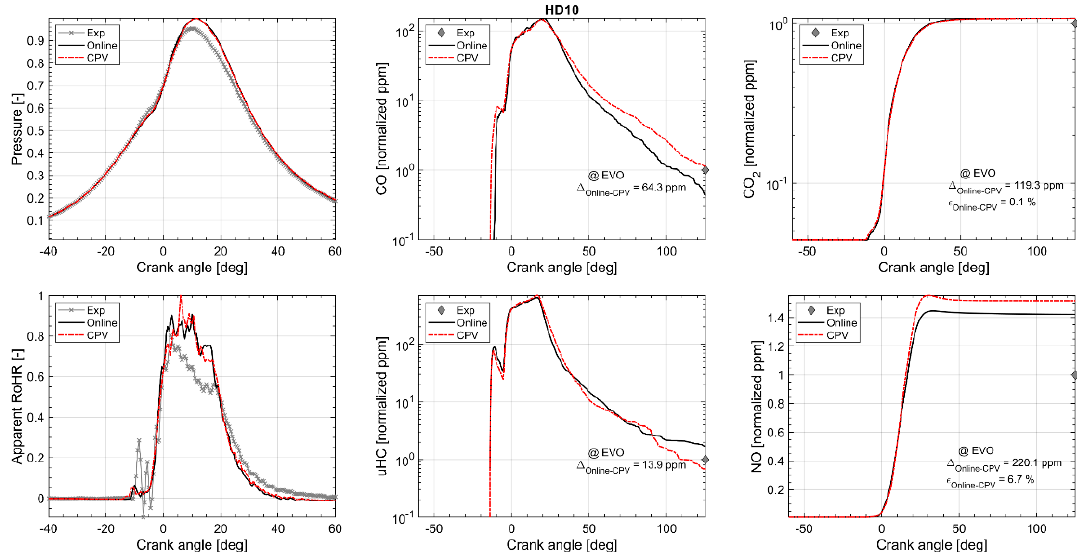
Figure A10. Engine performance and emissions for operating point HD10 (1000 rpm, 22.0 bar IMEP).